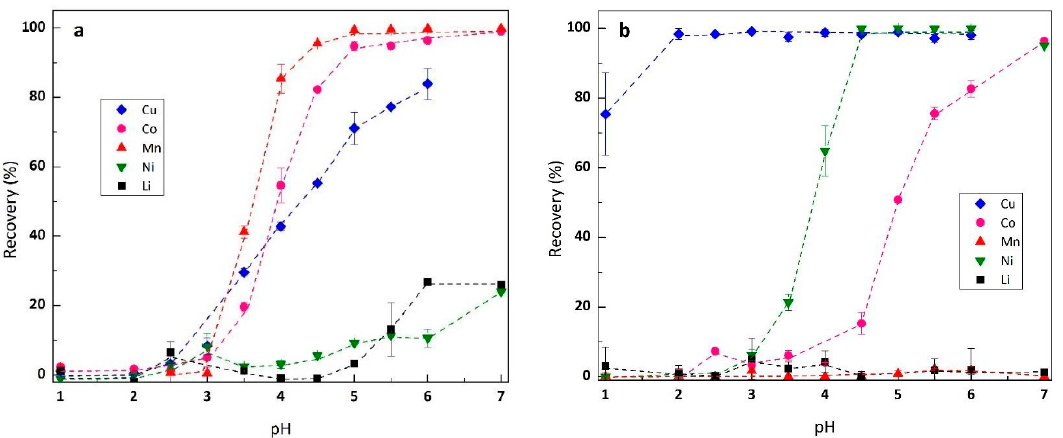
Figure 1. The extraction rate of the metal ion by ( a ). Cyanex ® 272 10% v / v and ( b ). LIX ® 84-I 10% v / v according to the initial pH of leach liquor.